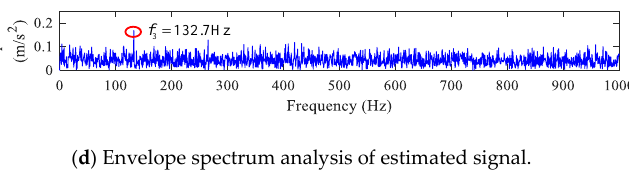
Figure 7. Results of experimental ball fault signal.